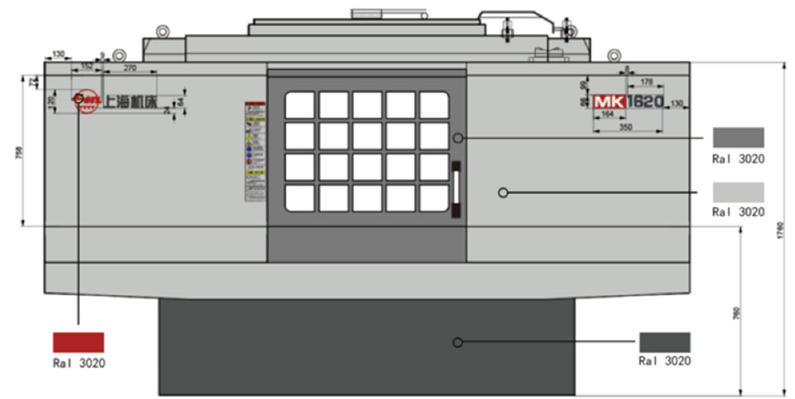
Figure 7. The final layout scale of the logo and model.